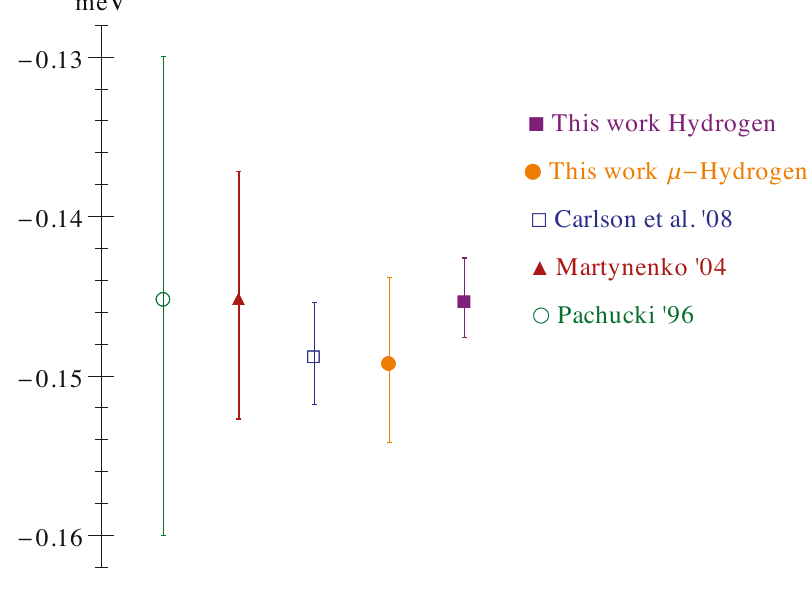
Figure 4 . Different predictions for δ ¯ E TPE